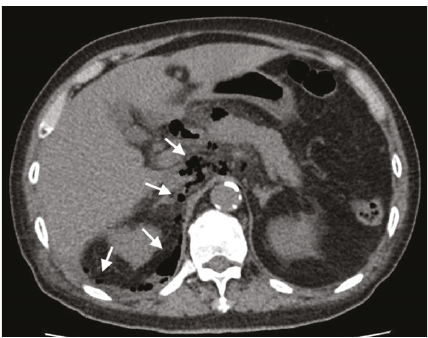
Figure 2: CT scan of abdomen at the level of the pancreas showing pneumoperitoneum with retroperitoneal air involving the right perinephric region.